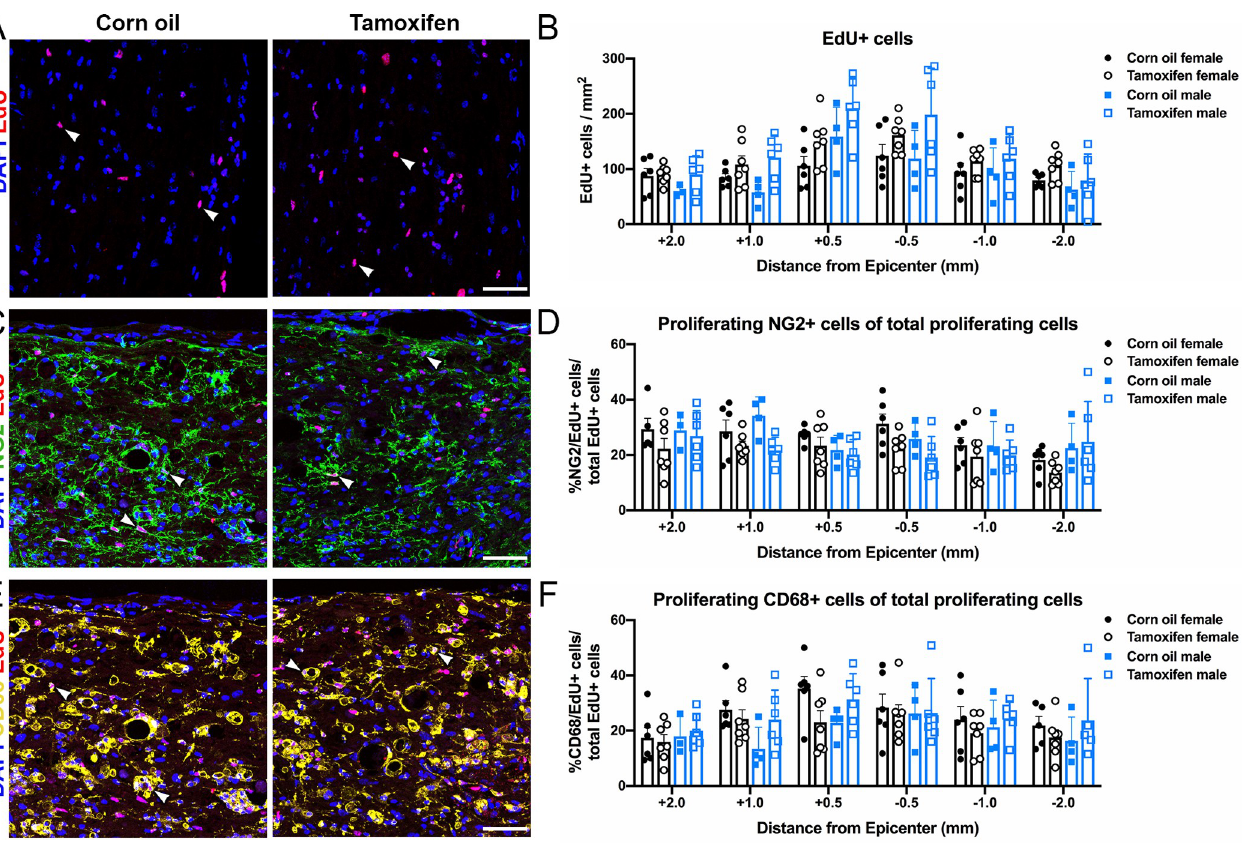
Fig 7. Delayed short-term tamoxifen treatment does not alter cell proliferation. (A, C, E) Representative confocal images of (A) proliferating cells (EdU/ DAPI+ cells), (C) proliferating NG2 cells (NG2/EdU/DAPI+ cells), and (E) proliferating phagocytic macrophages/monocytes (CD68/EdU/DAPI+ cells) in the lateral white matter of control and tamoxifen mice. Scale bar = 75 μ m. (B) Quantification of the total number of proliferating cells 2 mm, 1mm, and 0.5 mm rostral and caudal to the lesion epicenter. (D, F) Percent of proliferating (D) NG2 cells and (F) phagocytic macrophages/monocytes normalized to total proliferating cells at each sample distance rostral and caudal to the lesion. (B, D, F) The data are not significantly different between control and tamoxifen mice or female and male mice at any distance from the lesion epicenter. Data presented as mean + SEM. Mixed-effects analysis with Sˇı´da´k post hoc test; corn oil female n = 6; tamoxifen female n = 7; corn oil male n = 5; tamoxifen male n = 6.